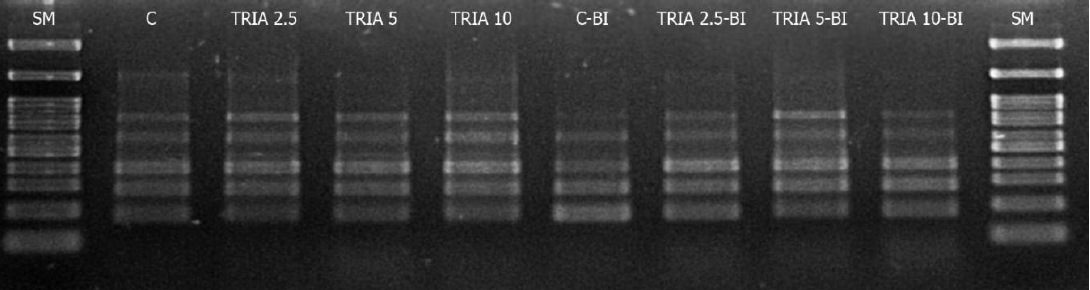
Figure 5. ISSR profile of shoot culture of D. forrestii — results for primer 840; lanes: SM — Fast gene ruler 100 bp, MS medium containing: TRIA (µg/L) or TRIA (µg/L) and 0.5 mg/L BAP and 0.2 mg/L IAA (TRIA-BI), C-medium without growth regulators, C-BI- medium with 0.5 mg/L BAP and 0.2 mg/L IAA.